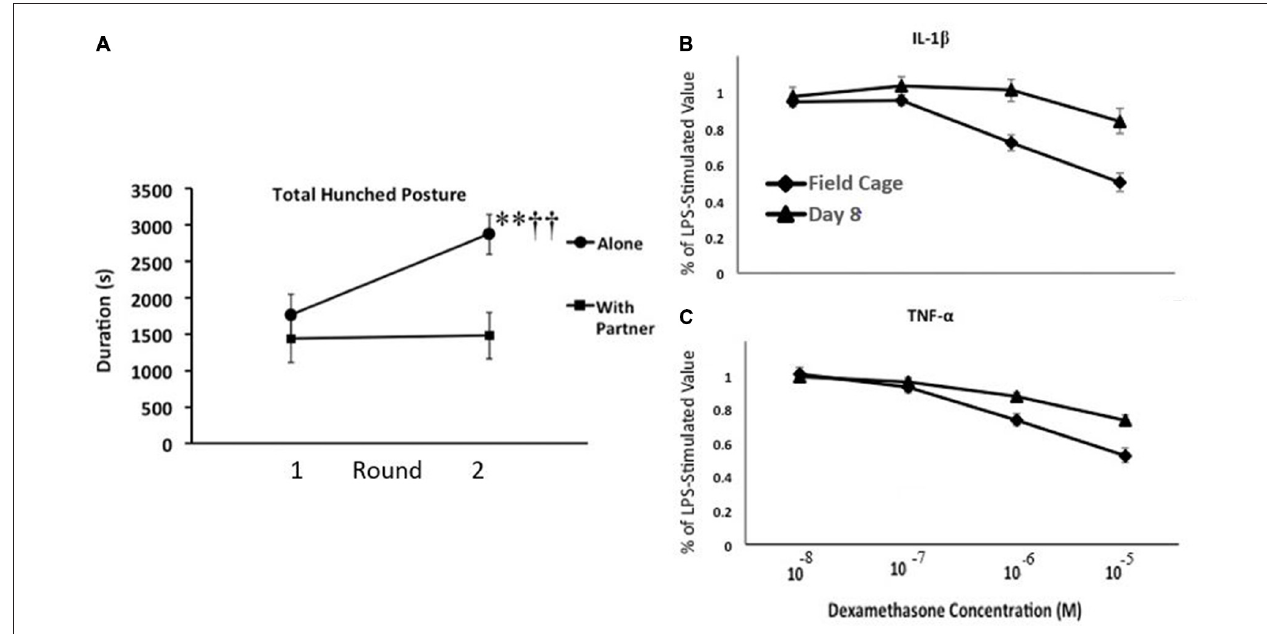
FIGURE 3 | (A) Mean number of seconds that adult male rhesus brought from spacious outdoor social groups to indoor housing either alone or with a partner exhibited the depressive-like hunched stance during 2, 8-day rounds of indoor housing at a 2-week interval. Monkeys housed alone exhibited a sensitization of depressive-like behavior from the first to the second round of indoor housing ( ∗∗ p < 0.001), so that they exhibited more of the behavior than did pair-housed monkeys during the second round ( †† p < 0.001), but not the first. (B,C) Mean percentage of lipopolysaccharide (LPS)-stimulated values of interleukin-1 β (IL-1 β ; B ) and tumor-necrosis factor alpha (TNF- α ; C ) following addition of various doses of dexamethasone. Blood was collected when monkeys were housed in field cages in large social groups and following 8 days of indoor housing. The higher doses of dexamethasone had less of a suppressive effect on both cytokines following 8 days indoors ( p ’s < 0.01). For both panels, vertical lines represent standard errors of the means (figure derived from Hennessy et al., 2017a with